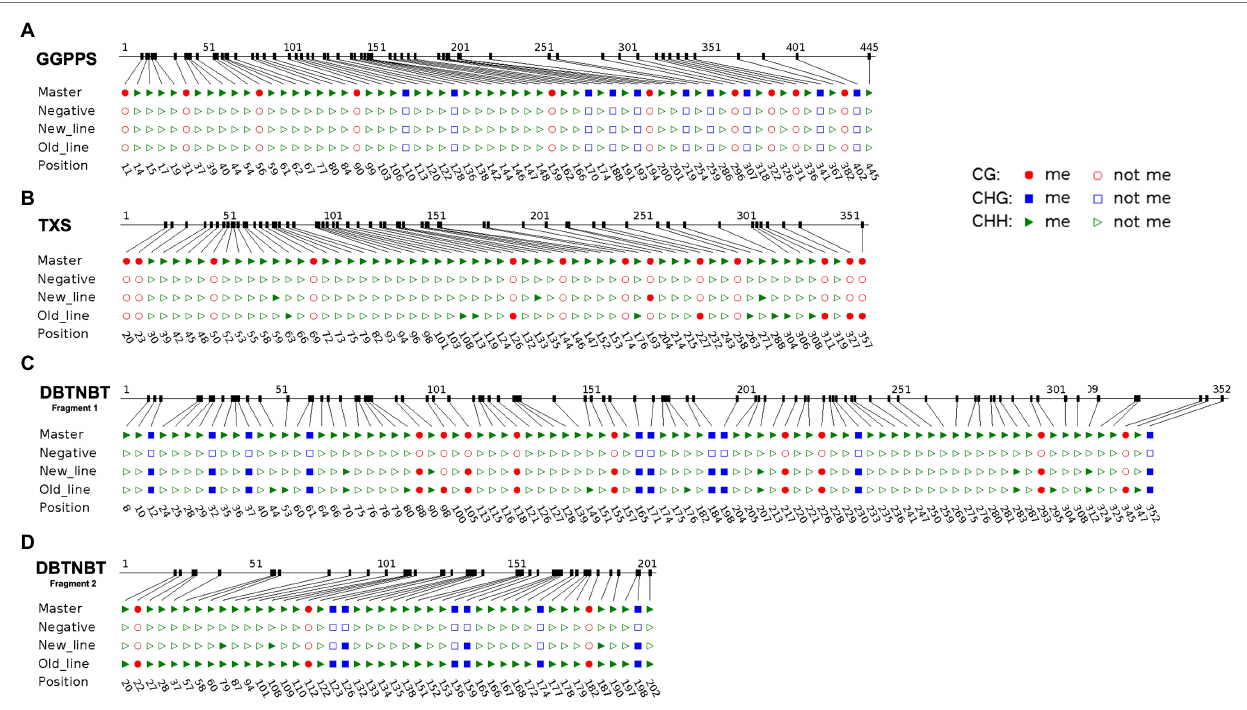
FIGURE 1 | Bisulfite-sequencing methylation analysis of the partial promoter region in the old and the new Taxus x media cell line. (A) GGPPS partial promoter. (B) TXS partial promoter. (C) DBTNBT partial promoter 352 nucleotides before TSS, fragment 1. (D) DBTNBT partial promoter from TSS to CDS, fragment 2. Master and negative sequences correspond to the untreated and the unmethylated sequences, respectively. The three different cytosine contexts are indicated in red spheres (CG), blue squares (CHG) and green triangles (CHH), colored (methylated) or empty (not methylated).